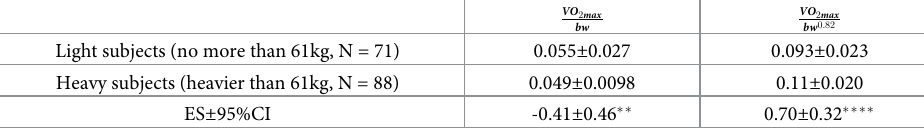
Table 5. Relative VO 2max expressed by different models in subjects with light or heavy body